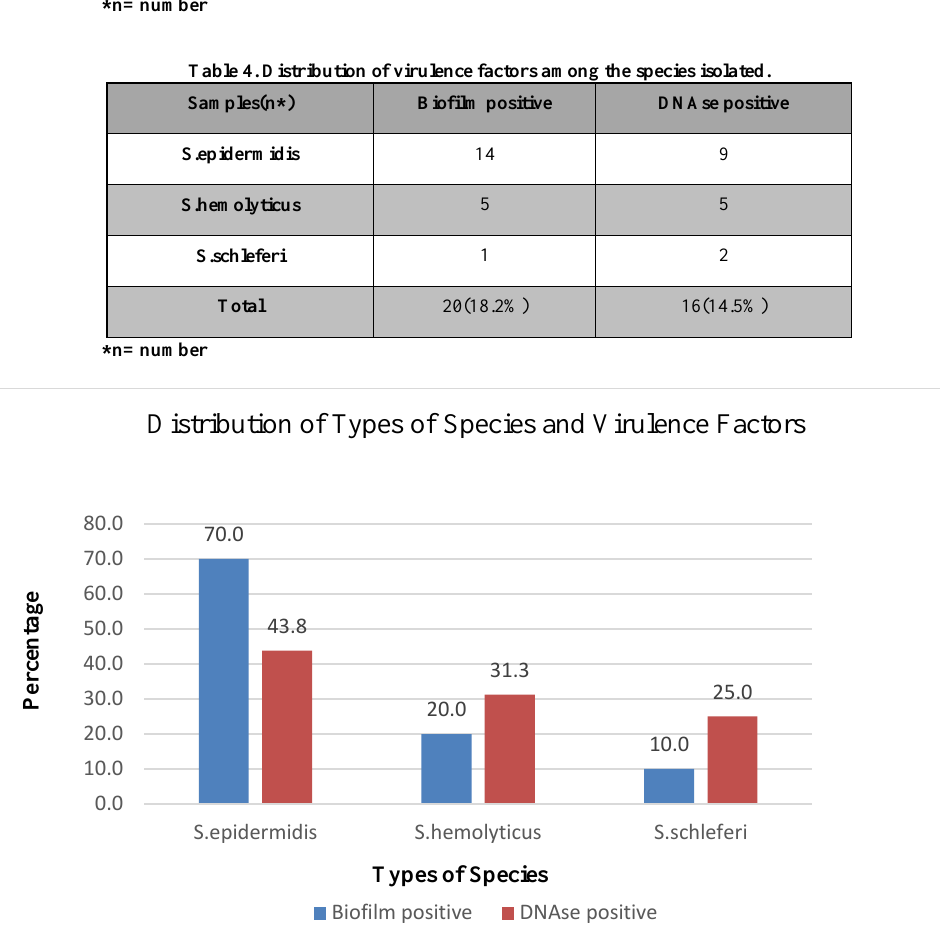
Fig. 3. Distribution of virulence factors among the species